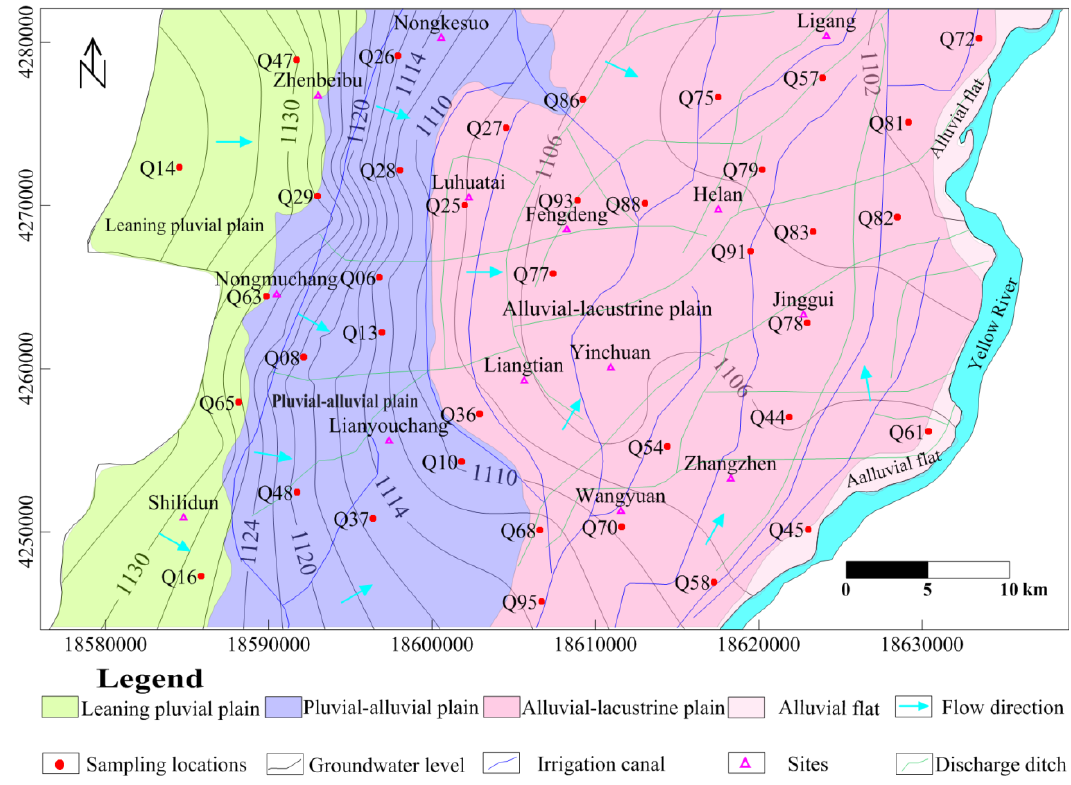
Figure 2. Hydrogeological map of phreatic aquifer and sampling stations in the study area